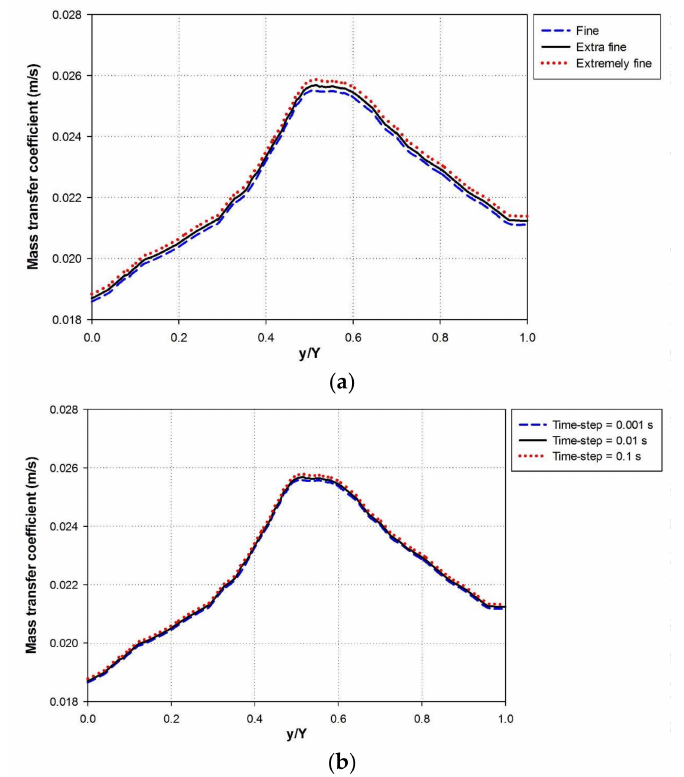
Figure 2. ( a ) Grid independence and ( b ) time-step independence tests for a raceway pond with AR = 10, water depth = 0.2 m, and paddle wheel paddle wheel speed =